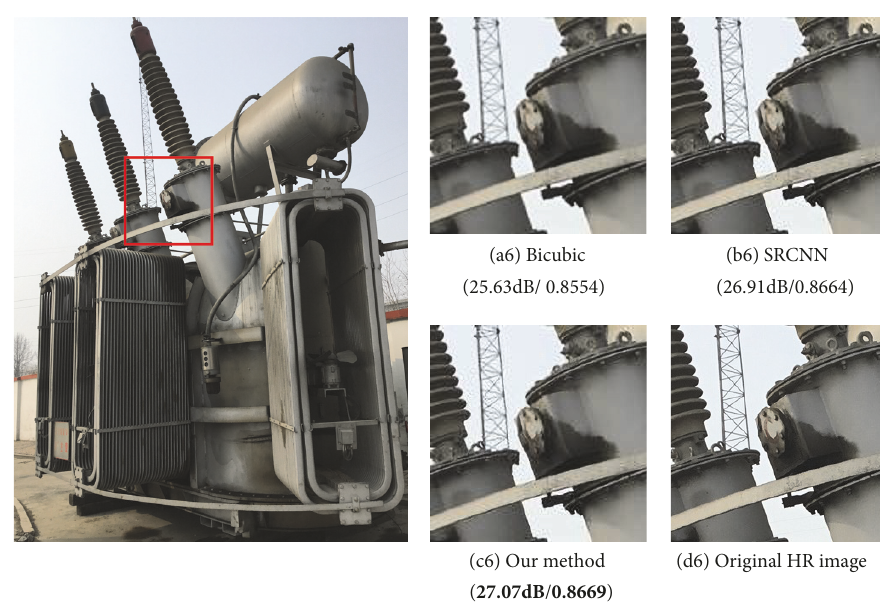
Figure 10: Oil leak in the transformer’s oil pillow.